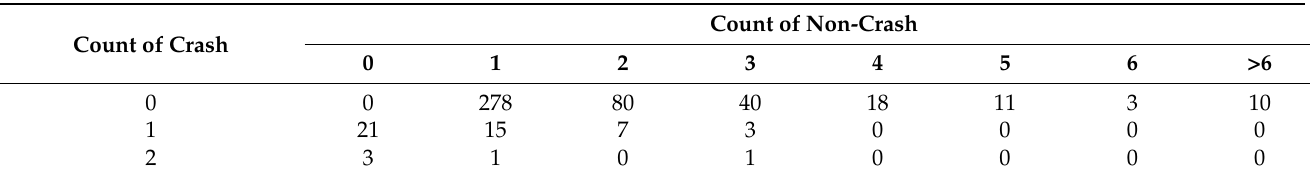
Table 6. Cross-tabulation of non-crash and crash